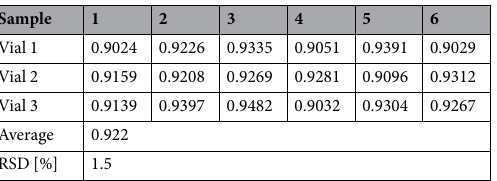
Table 4. Quantification of the mass fraction of porcine insulin in solid by LC-CD [g/g].